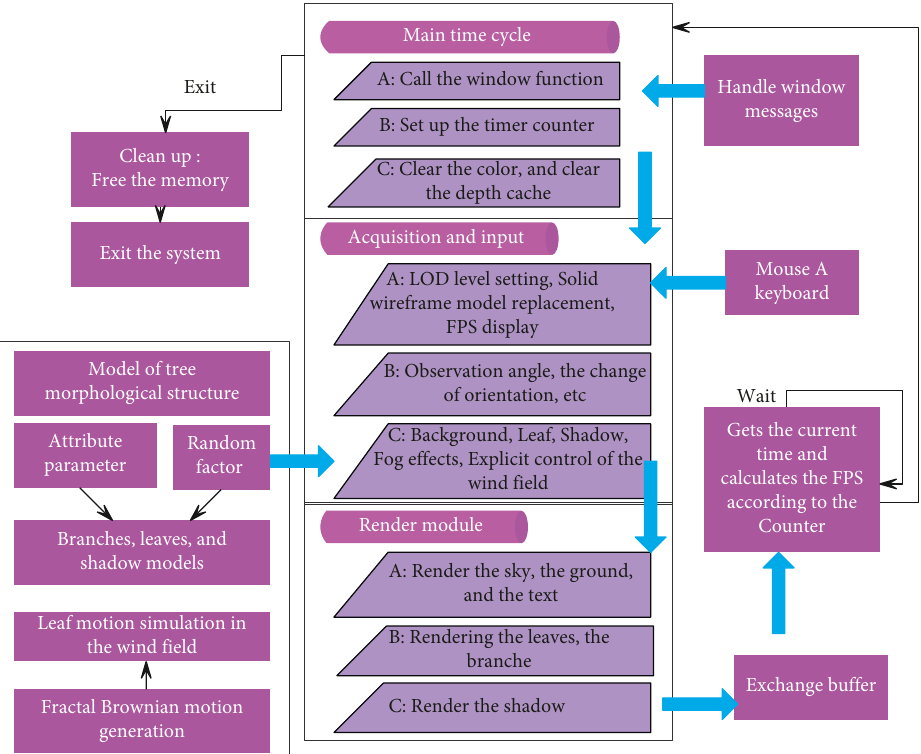
Figure 8: Implementation process of virtual tree demonstration system.